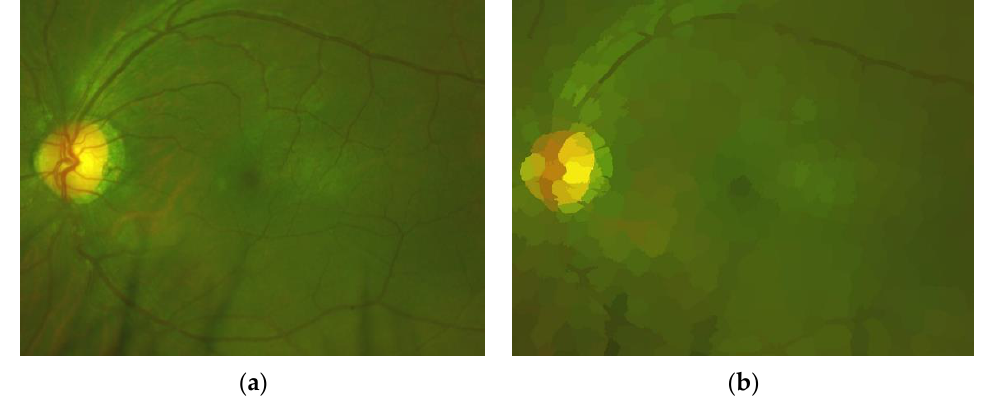
Figure 8. ( a ) Original ROI and ( b ) ROI represented by super-pixels.